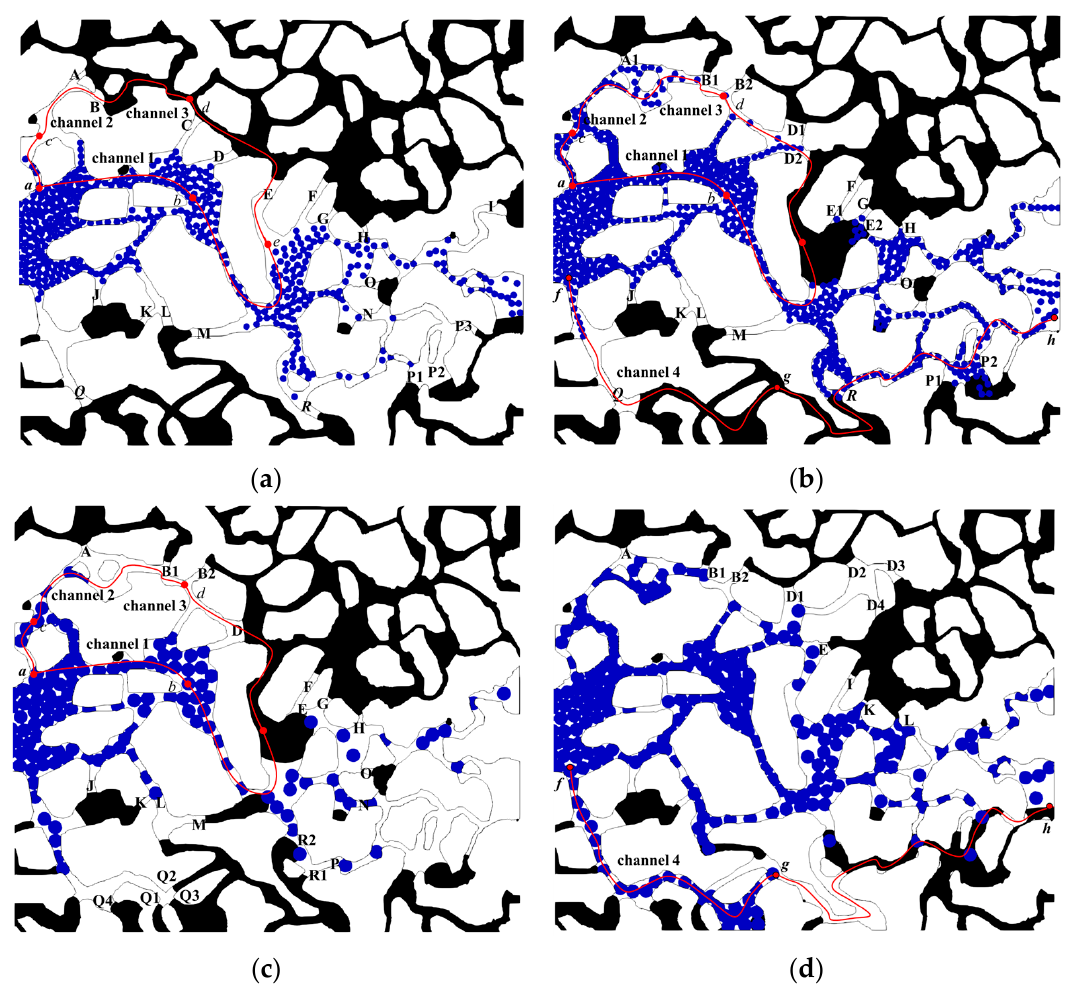
6 Figure 6. Particle–water–oil distribution at 0.5 and 1 s in case I (continuous injection) and case II (continuous injection): ( a ) case I at 0.5 s; ( b ) case I at 1 s; ( c ) case II at 0.5 s; ( d ) case II at 1